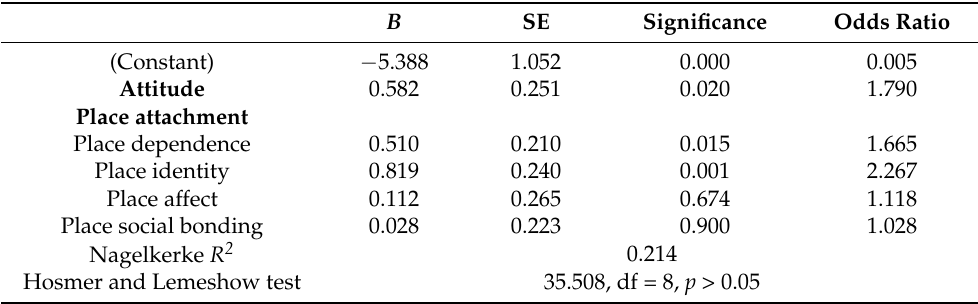
Table 3. Logistic regression analysis of positive votes and negative votes in willingness to pay (n = 400).